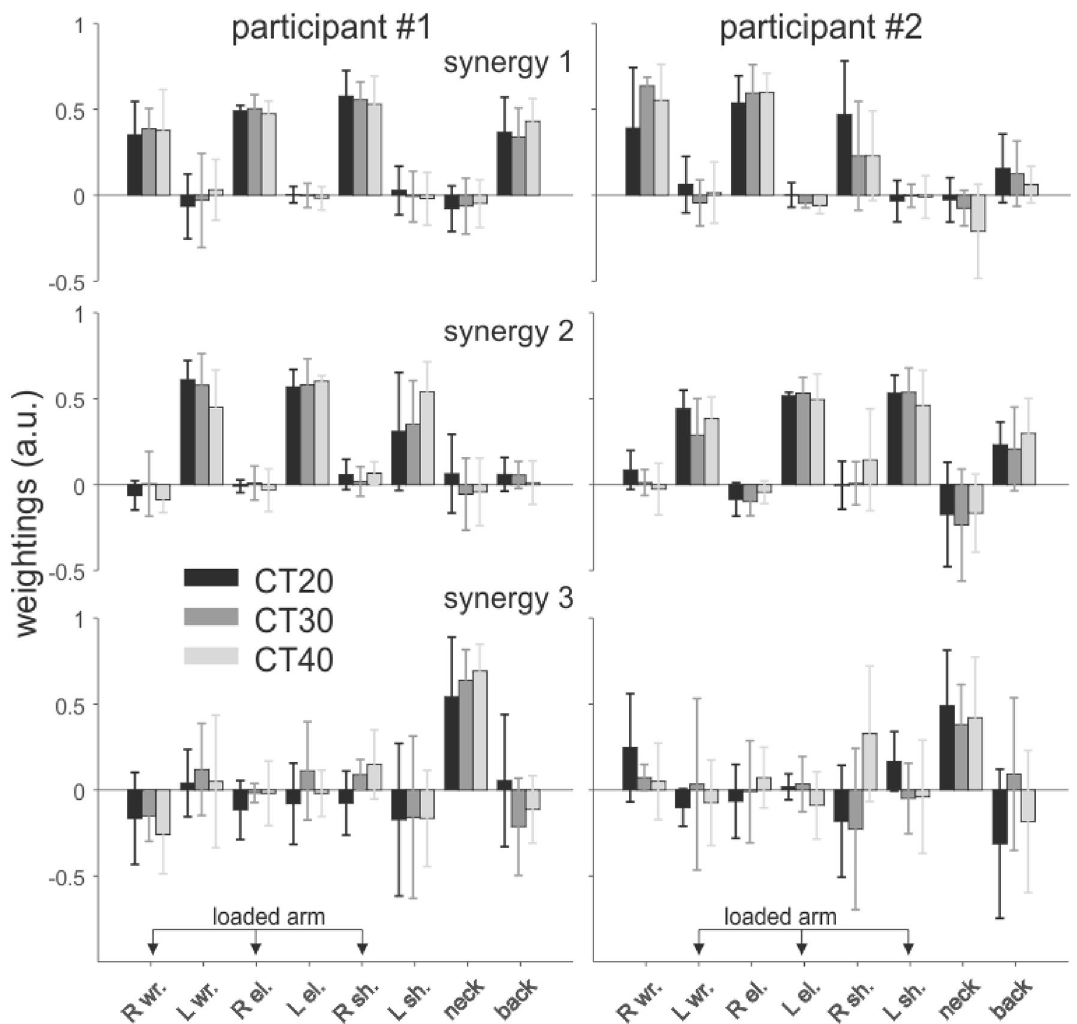
Figure 6. Individual synergy vectors. Mean (± SD, in arbitrary units) joint moment weightings of each synergy vector, for each participant, and across each condition. The vectors were normalized to unit length. R and L stand for right and left, respectively, wt. for wrist, el. for elbow, and sh. for shoulder. The loaded arm is indicated for each participant in the pair. In front view participants #1 and #2 were positioned on the right and left side of the load, respectively.